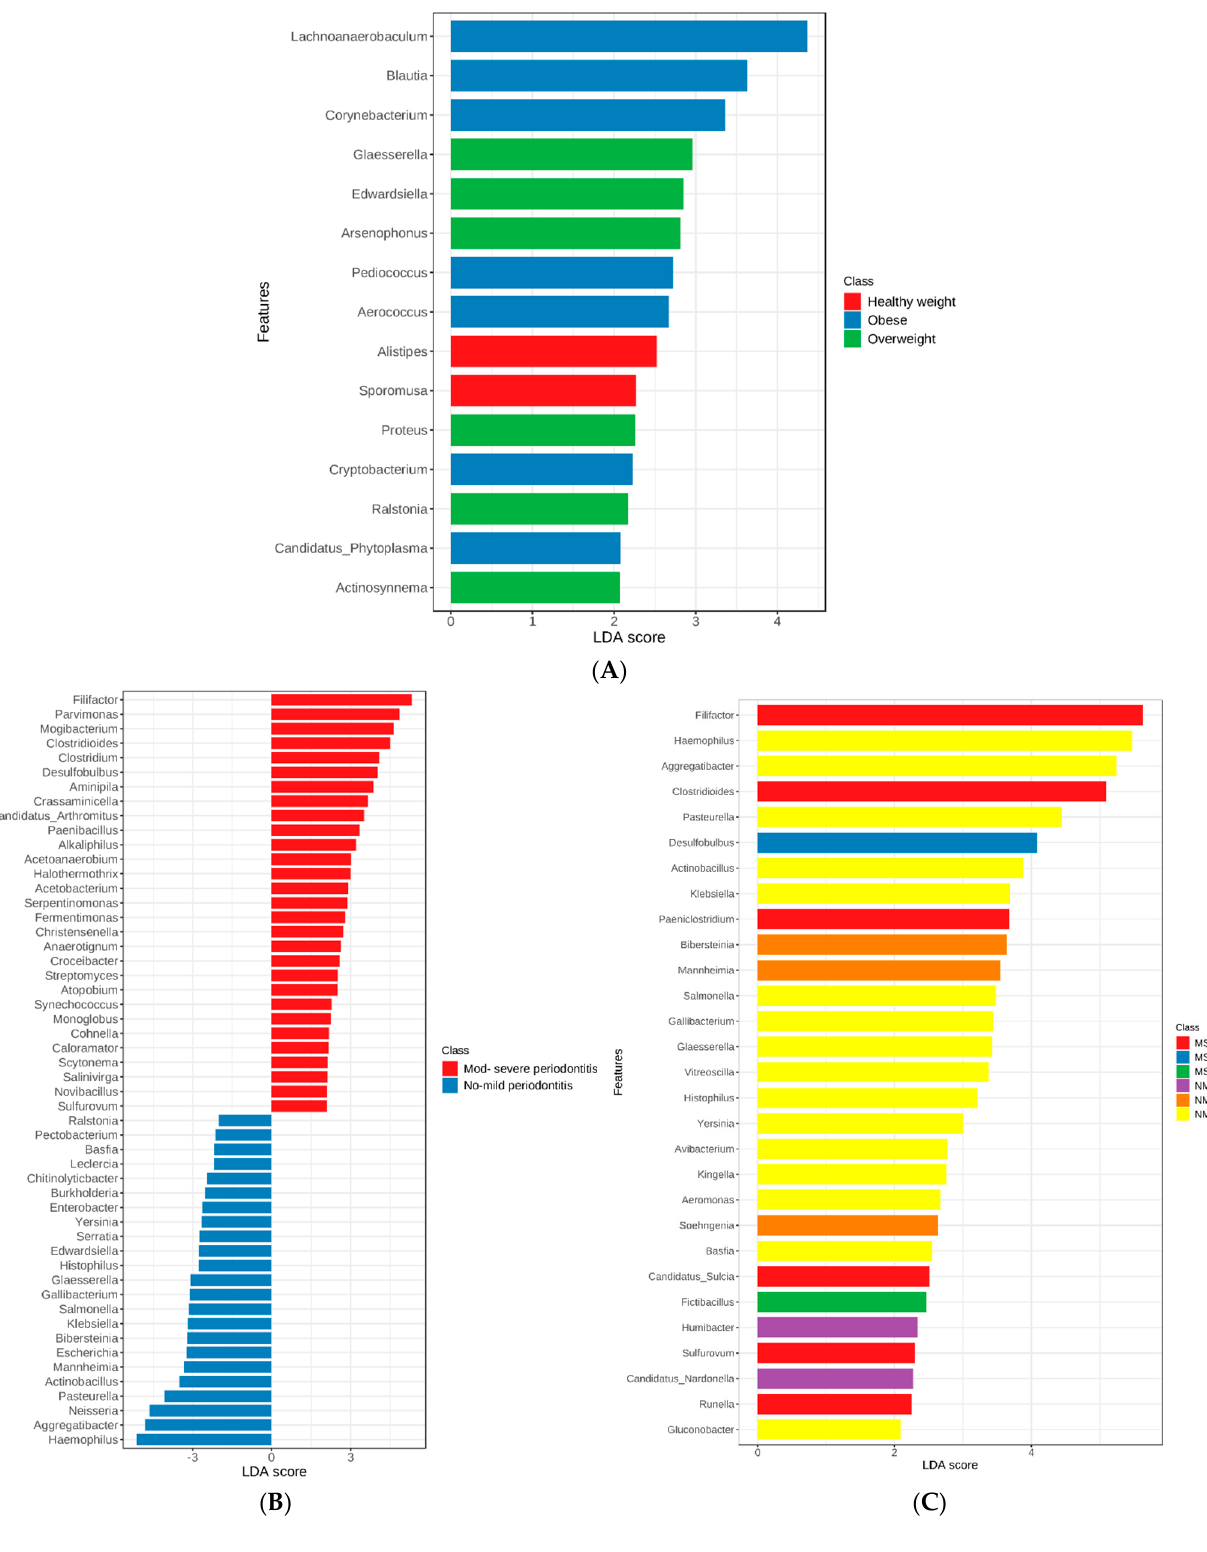
Figure 4. Genera detected by linear discriminant analysis (LDA) effect size (LEfSe) in subjects grouped based on their BMI ( A ), periodontal health status ( B ), and considering both factors ( C ). The genera shown are those that were significantly different among the groups ranked based on LDA score. Horizontal bars represent the effect size for each taxon.